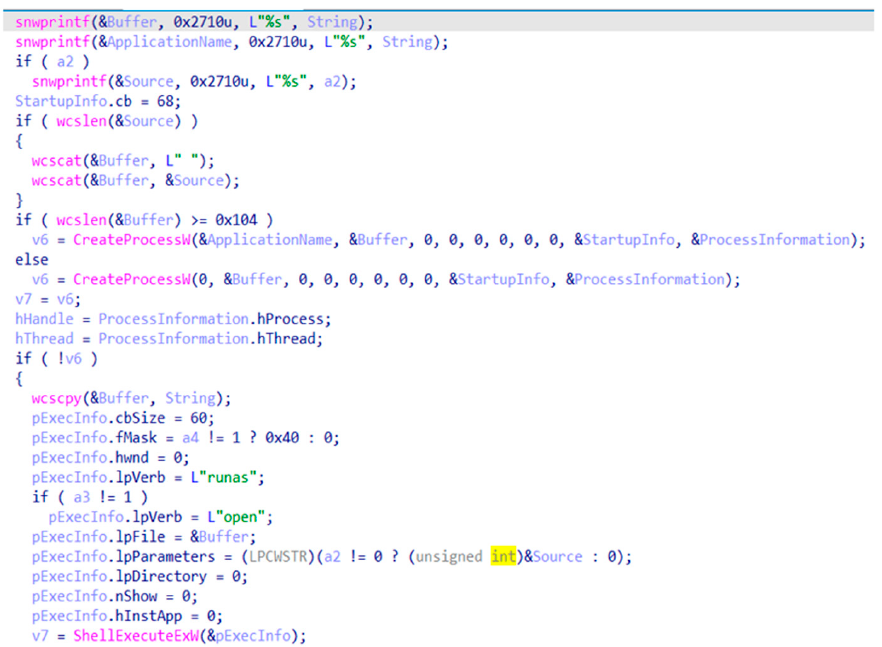
Figure A5. Code of process execution.